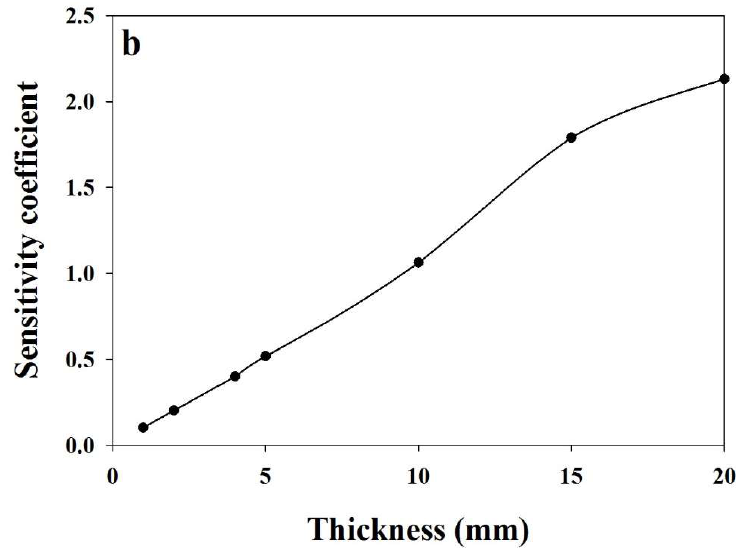
Figure 14. Sensitivity analysis of thickness of thermal screens ( a ) heating demand ( b ) sensitivity coefficient.